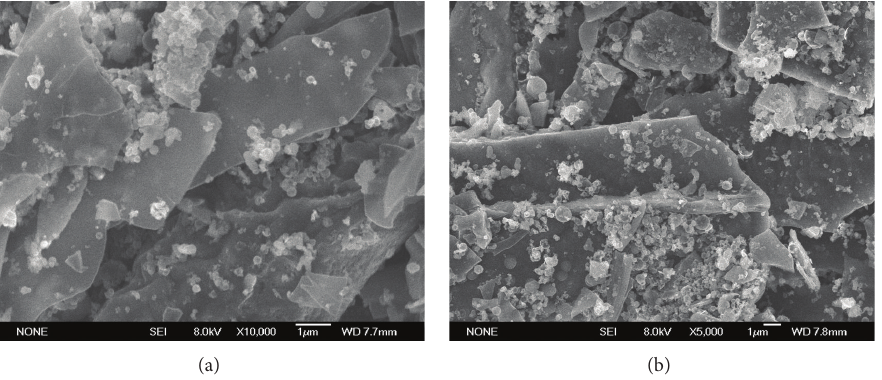
Figure 9: SEM pictures of the residue obtained in the cone calorimeter: (a) flame-retarded PA6 with ADPP; (b) flame-retarded PA6 with ADPP/ME.